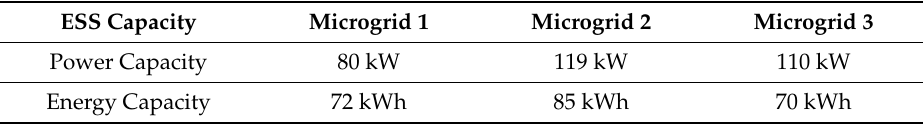
Table 5. ESS capacity of interconnected microgrid scheme with Objective